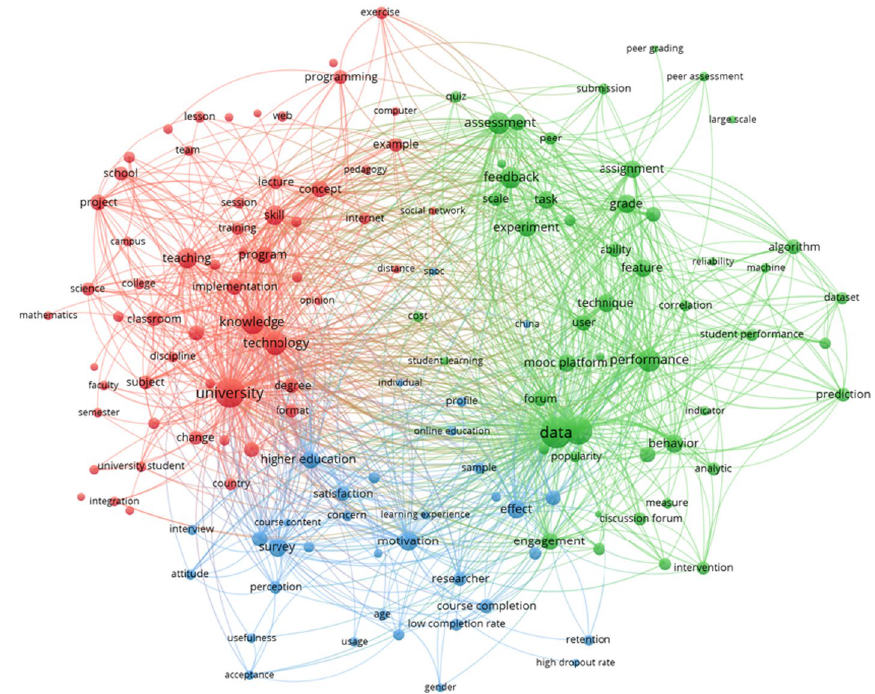
Fig. 5 Thematic cluster evaluation of MOOCs. Network